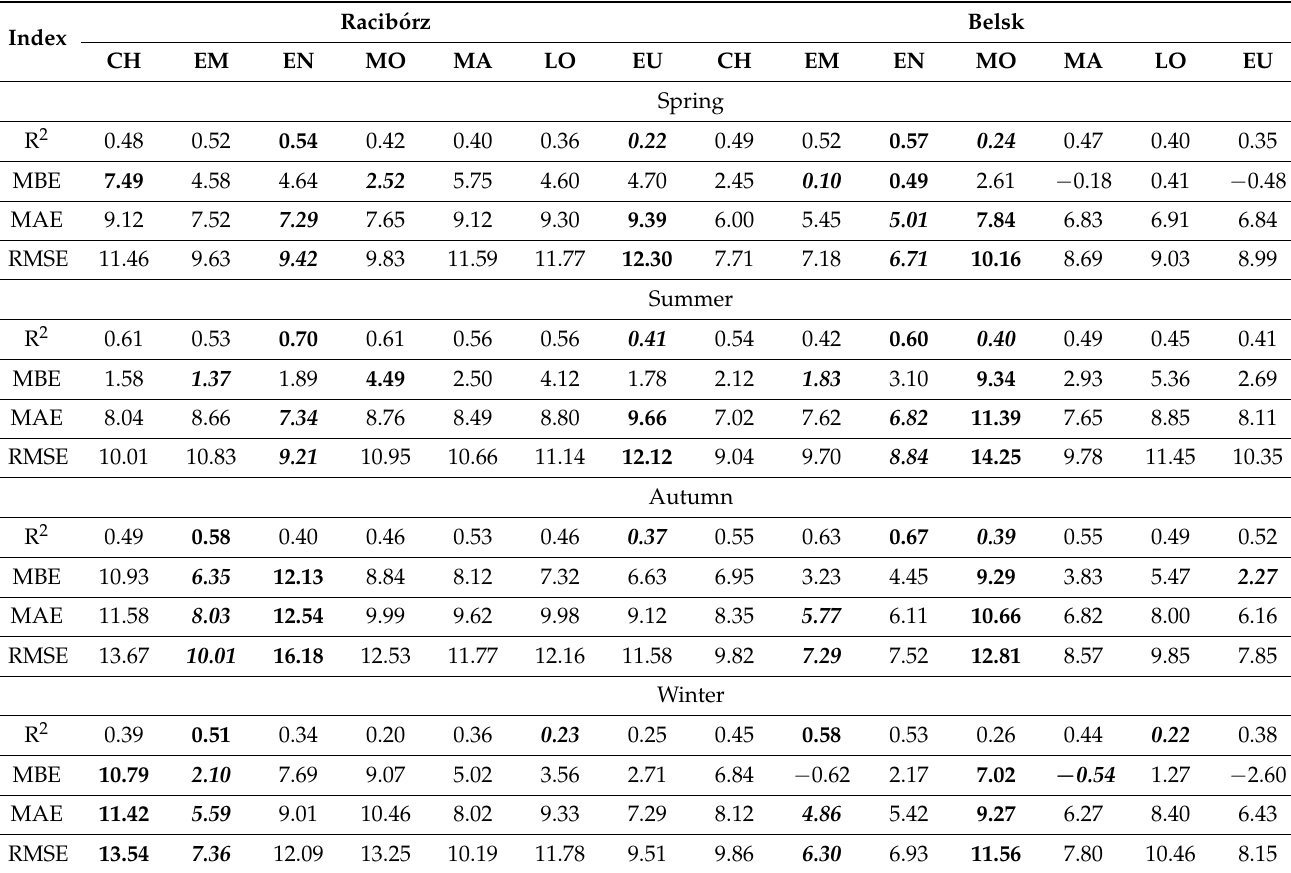
Table 2. Summary of comparative statistics of surface O 3 concentrations between measured and CAMS forecasts. MBE, MAE and RMSE are in